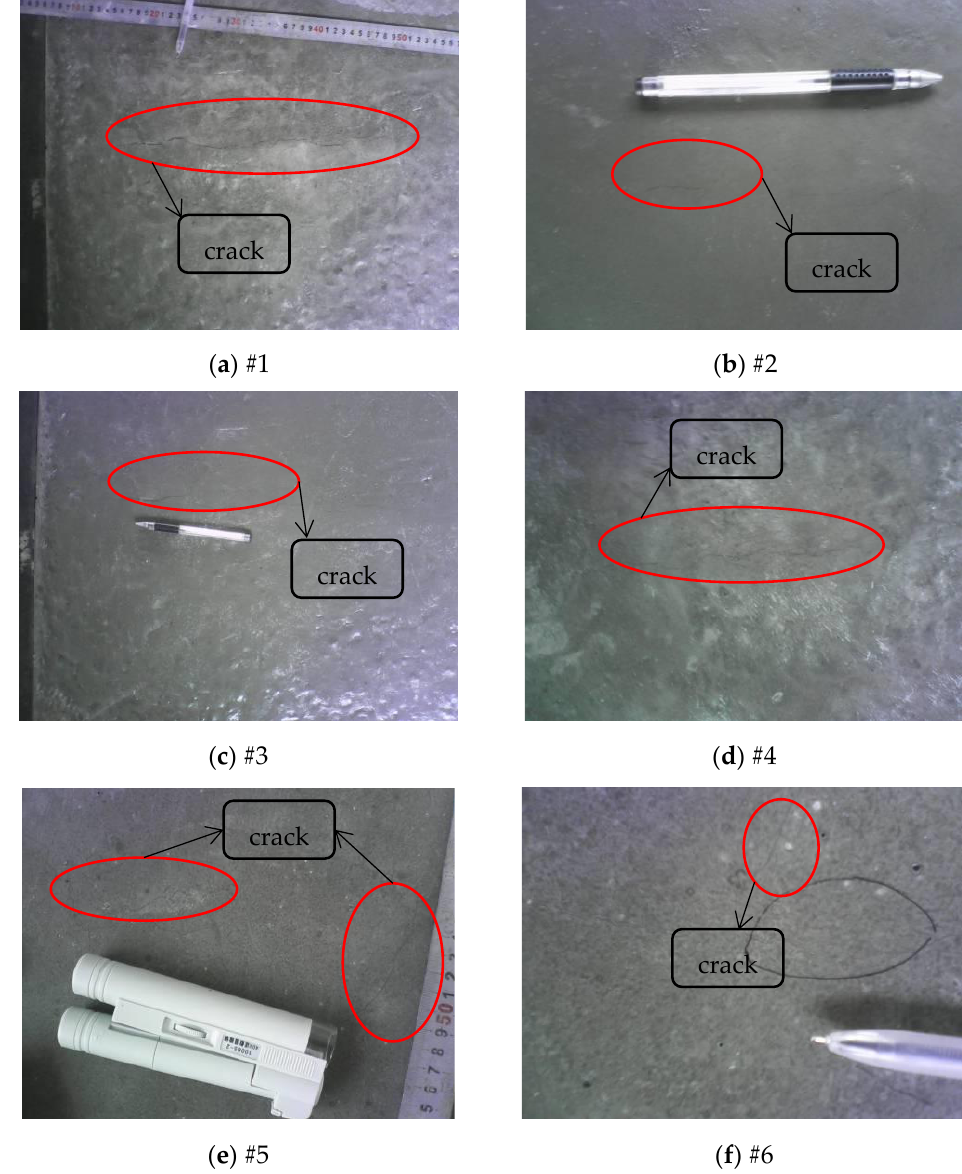
Figure 5. Characteristics of concrete cracks from ( a – f ).